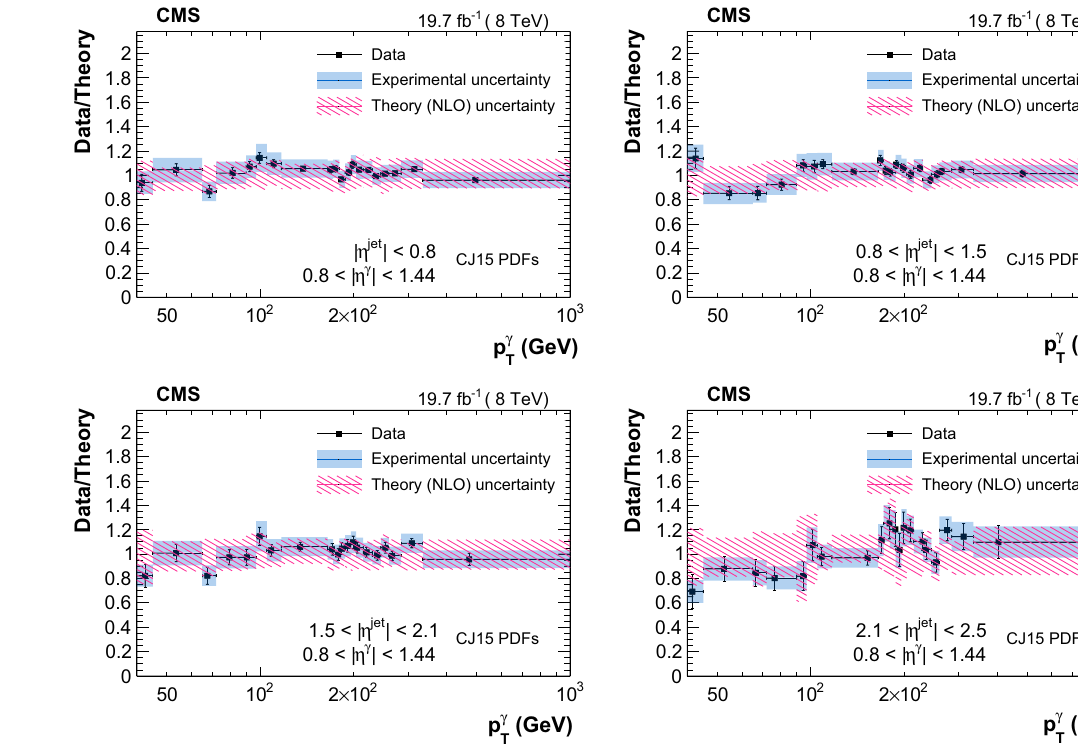
Fig. 6 Ratio of triple-differential cross sections as a function of p measured in data over the corresponding GamJet NLO theoretical pre- diction (obtained with the CJ15 PDFs) in different bins of | η jet | for